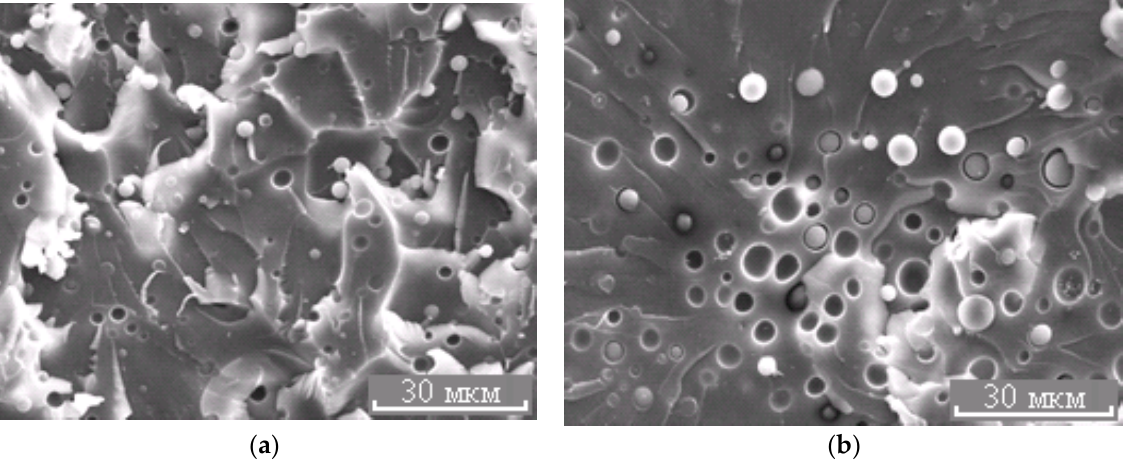
Figure 7. Morphology of the PES–EO mixture at φ PES 5 ( a ) and 10 wt.% ( b ).